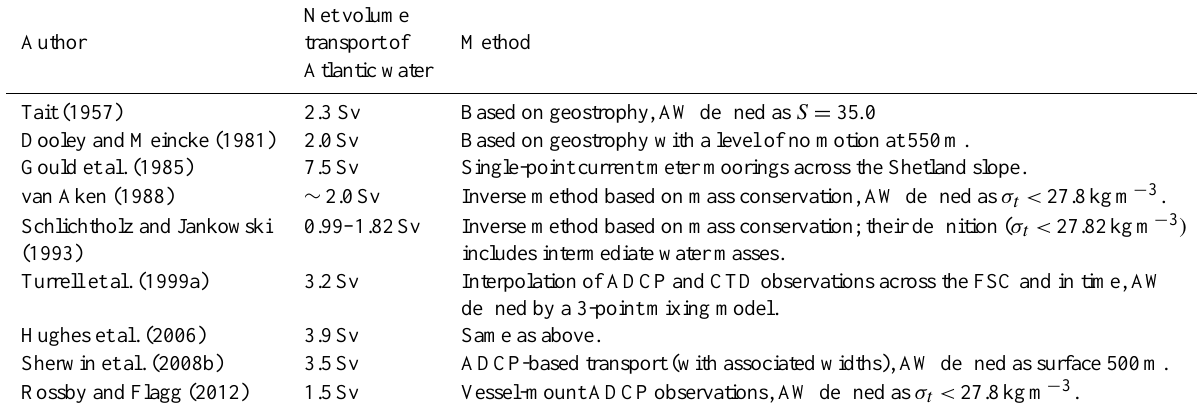
Table 5b. Historic estimates of the net volume transport of Atlantic water through the